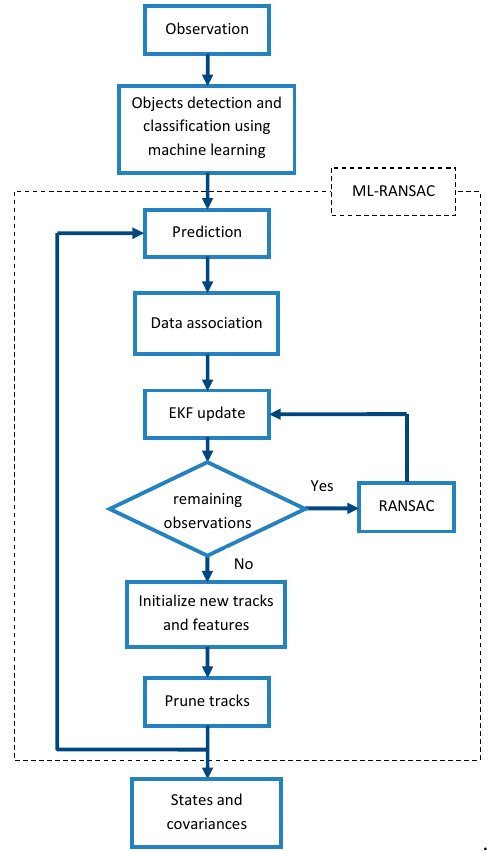
Figure 3. Overall scheme of multilevel-RANdomSAmple Consensus (ML-RANSAC) algorithm for Simultaneous Localization and Mapping with multi-target tracking